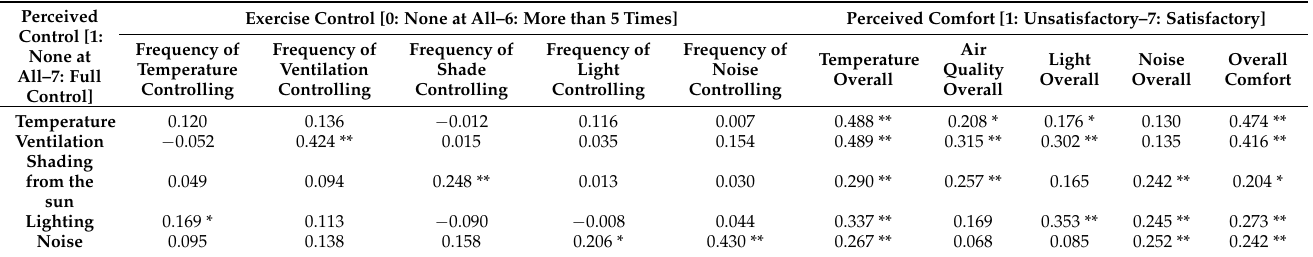
Table 2. Correlations between perceived control with exercise control and perceived comfort.